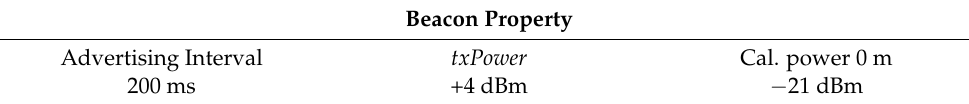
Table 1. Beacon’s configuration.